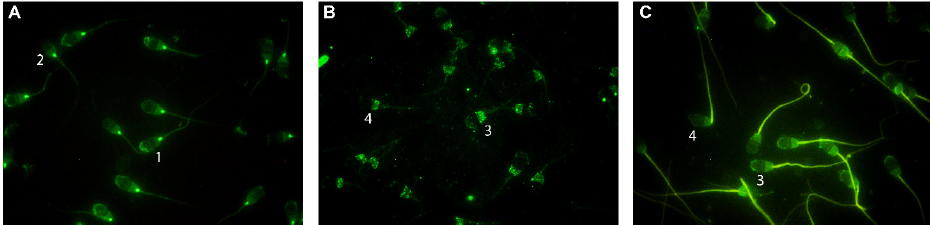
Figure 2. Indirect immunofluorescence (IFI) localization of nitric oxide synthase isoforms eNOS ( A ), nNOS ( B ) and iNOS ( C ) evaluated by fluorescence microscopy in ram spermatozoa. Two immunotypes can be seen in each isoform: labeling in postacrosomal region + neck + apical edge (1) or postacrosomal region + neck (2) in eNOS (A), postacrosomal region + apical edge (3) or postacrosomal region (4) in nNOS (B) and iNOS (C). Original magnification x1000.